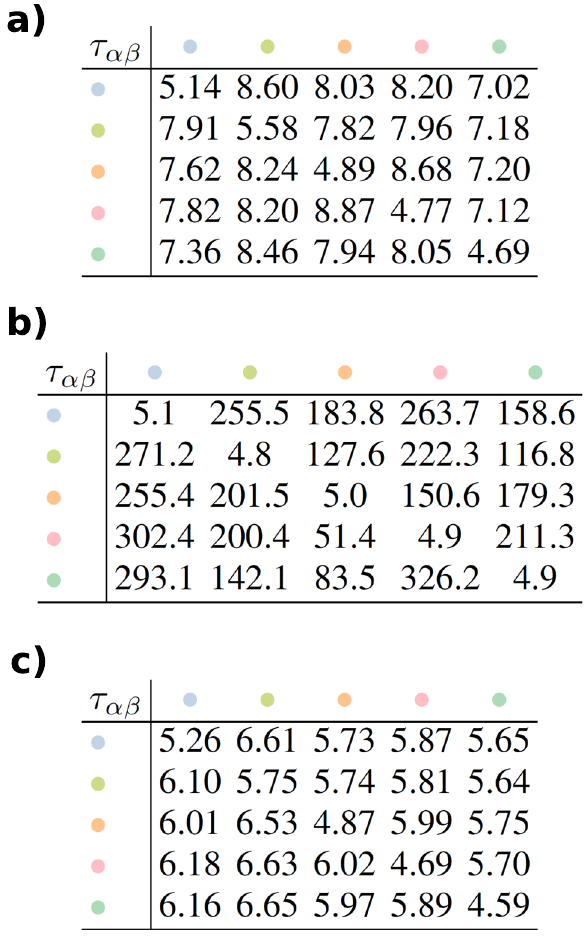
Fig. 2 Class mean fi rst passage times (CMFPT) in synthetic colour distributions. The class mean fi rst passage time (CMFPT) τ αβ is the expected number of steps a random walk needs to reach a node of class β when it starts from a node of class α . a The CMFPT from each class (left) to each other one (top) in the lattice shown in Fig. 1b, while in b we have the CMFPT between classes in the lattice with clusters of Fig. 1c. These values are computed from Eqs. (2) and (5). c Mean- fi eld approximation of CMFPT in Fig. 1b based on a clique of fi ve nodes and uniform transition probabilities (see Methods for